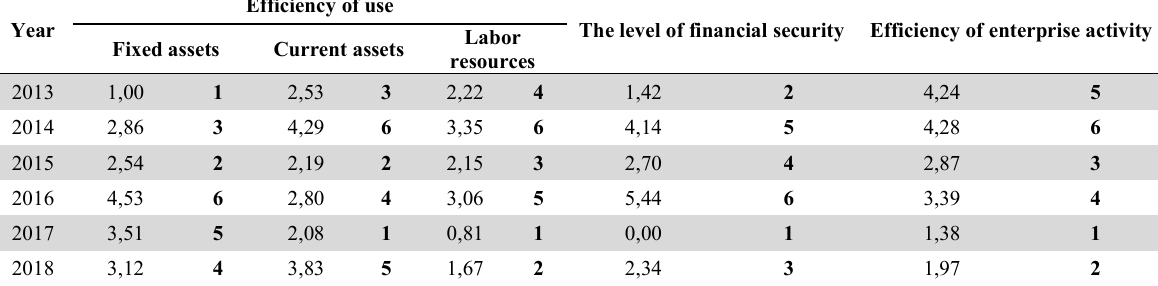
Interim results of integrated assessment of the development level of PJSC